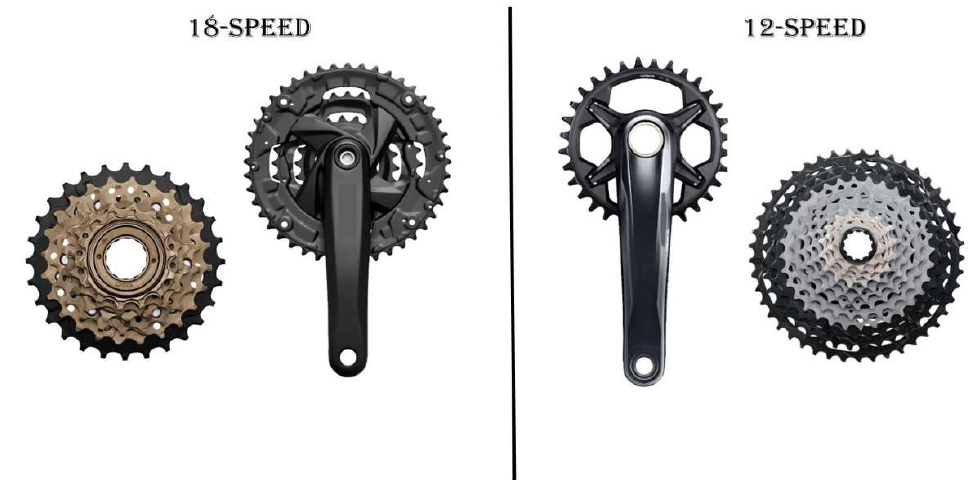
Figure 9. Most popular in the 1990s (18-speed) and more recent (12-speed) gear system models. Although the left system allows more speed combinations, the right one is more accurate, lighter, stronger, more efficient and easier to handle.